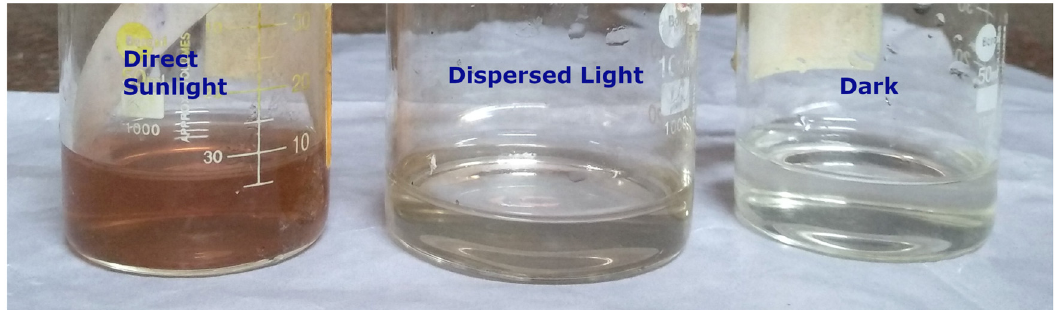
Figure 2: Solution mixture under di ff erent light conditions.